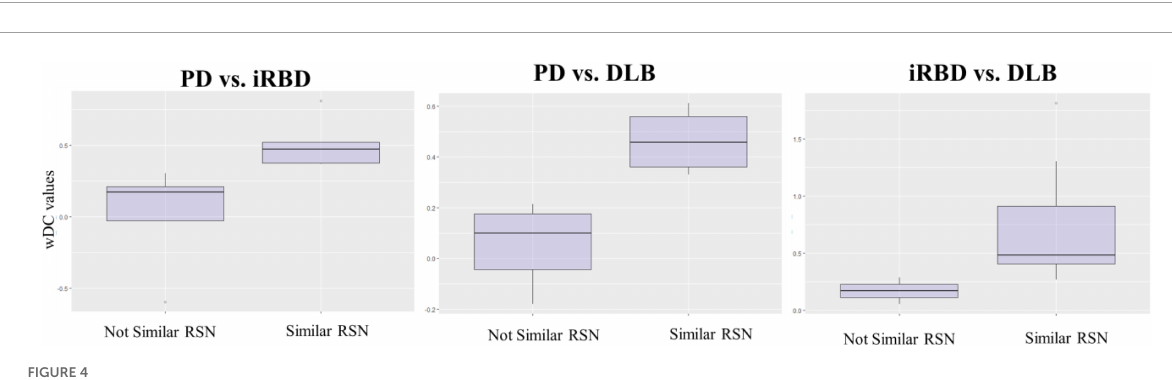
studies—similar to fMRI data—connectivity changes are often explained in terms of function. Decreased connectivity indicates the functional separation between regions, whereas increased connectivity indicates increased functional pairing (Pievani